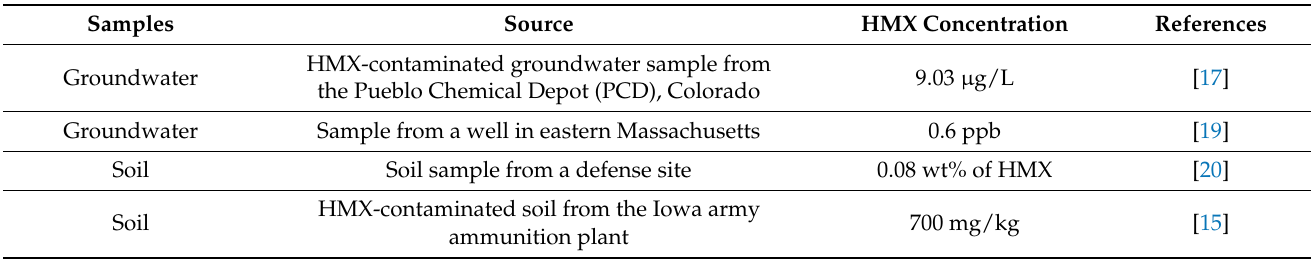
Table 1. The concentration of HMX in groundwater, wastewater, and soil